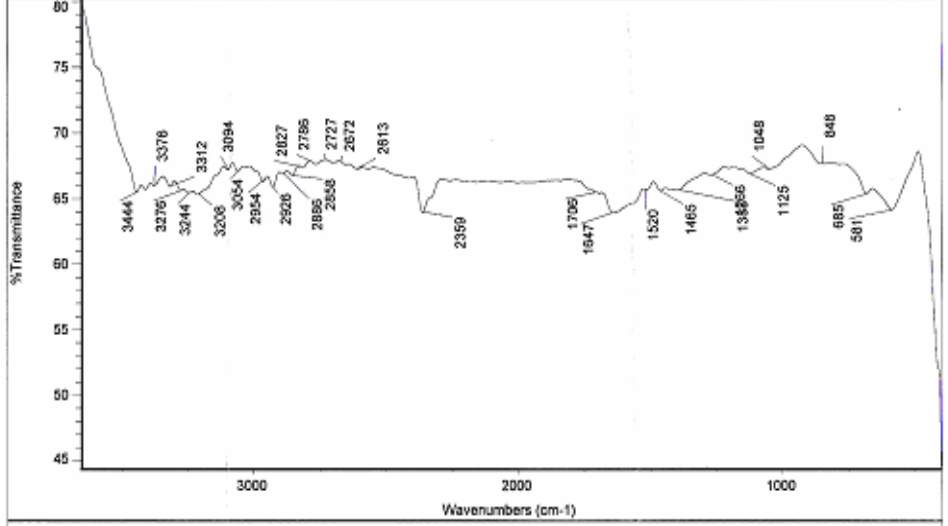
Figure 1 . FT-IR spectrum of